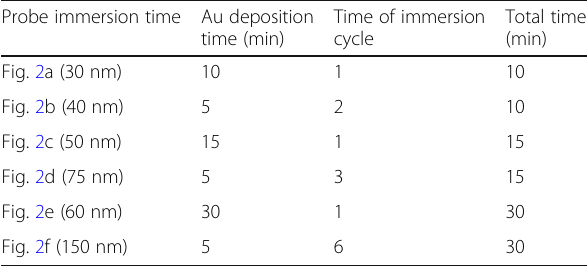
Table 1 The SEM images of probes and corresponding experimental